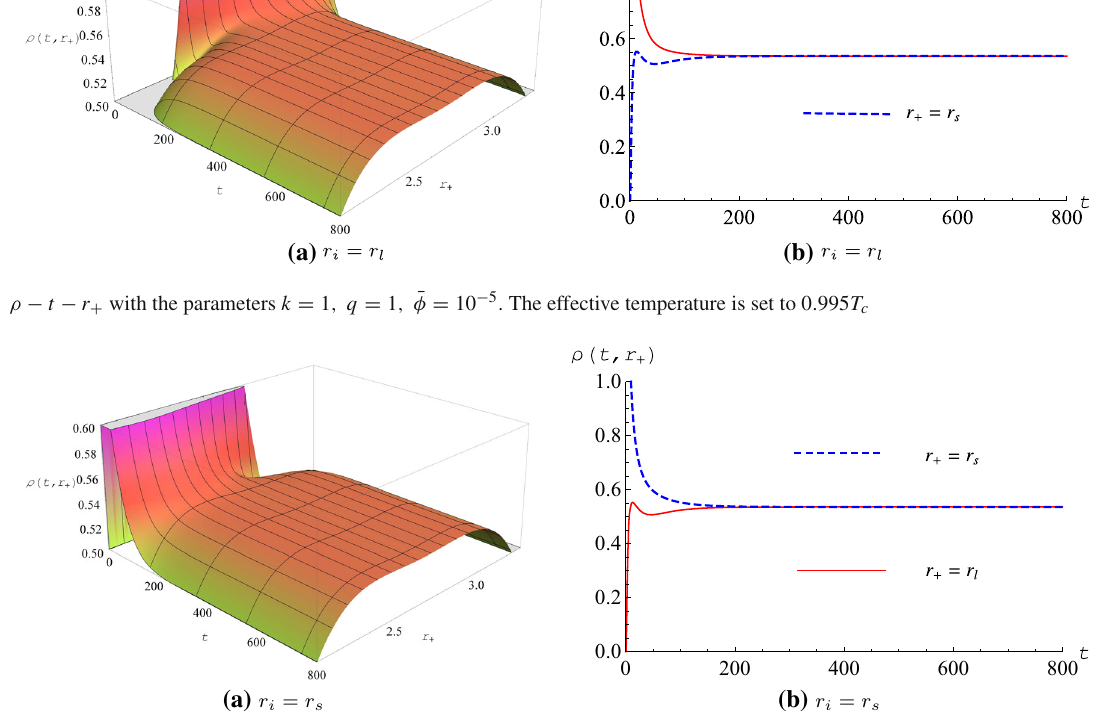
Fig. 7 ρ − t with the parameters k = 1 , q = 1 , ¯ φ = 10 − 5 . The effective temperature is set to 0 . 995 T